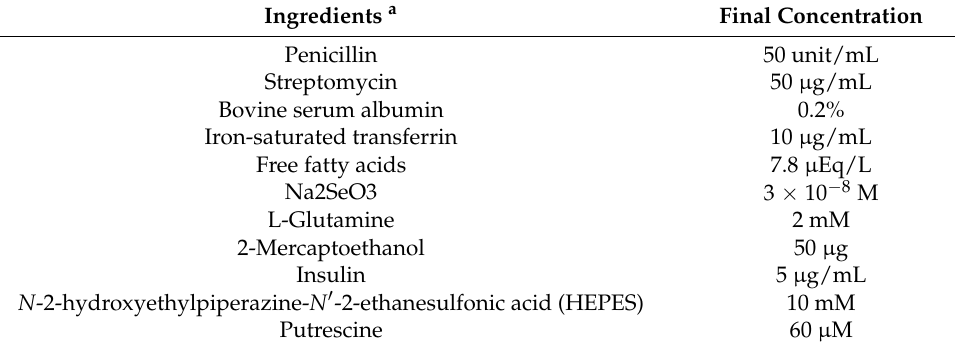
Table 1. Composition of mouse serum-free media (mSFM) . Ingredients